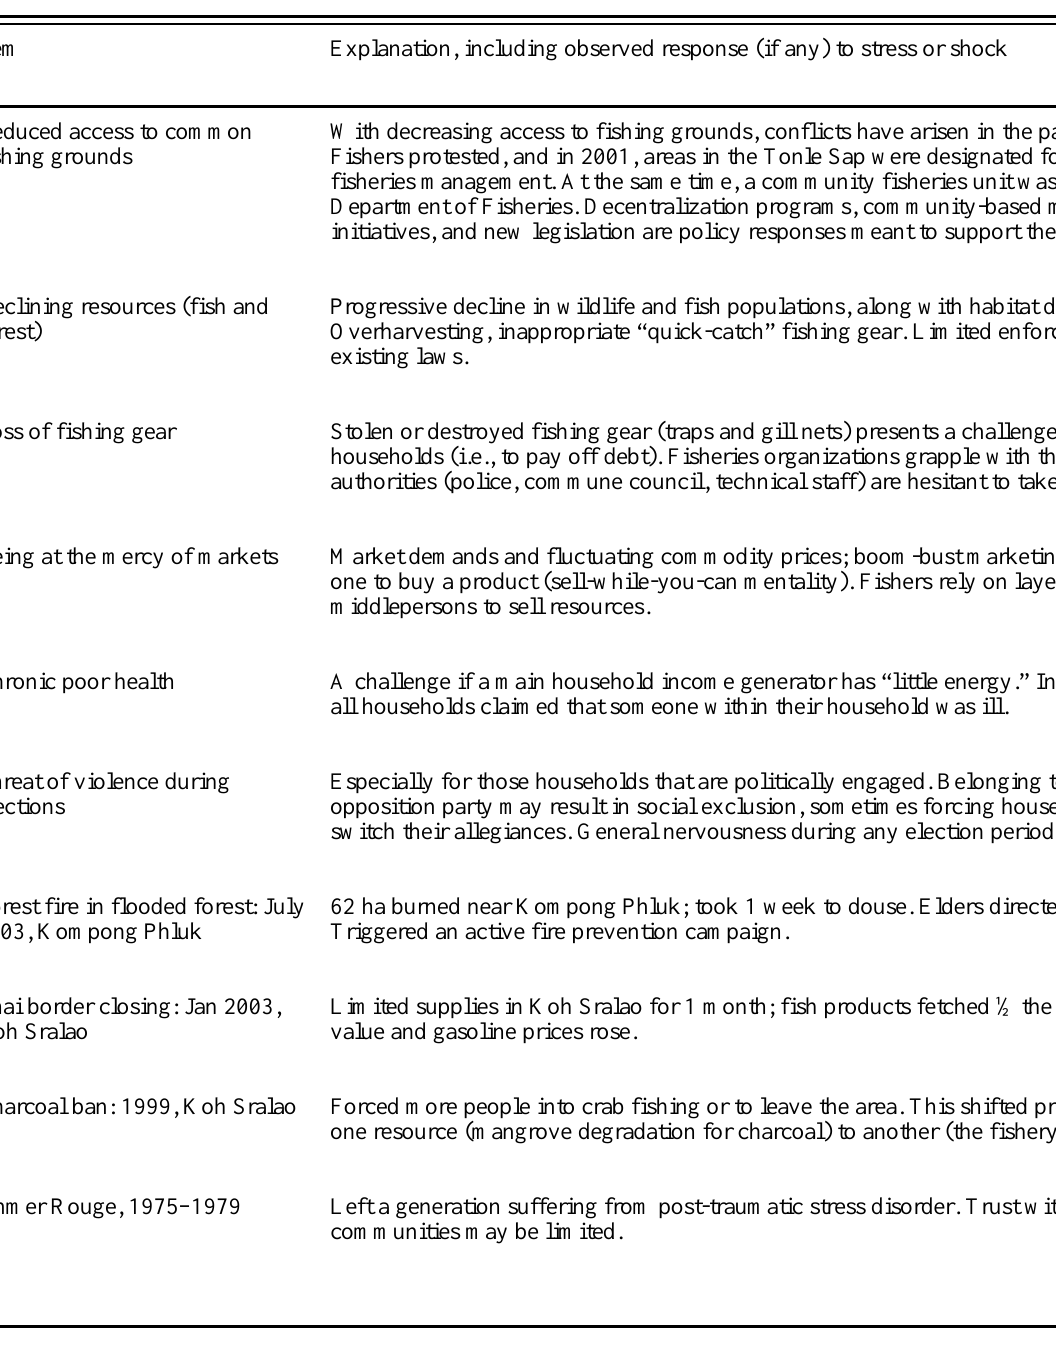
Table 1. Stresses and shocks found in the two fishing communities. The items at the top of the table are predominantly stresses, integrating into items at the bottom of the table that are predominantly